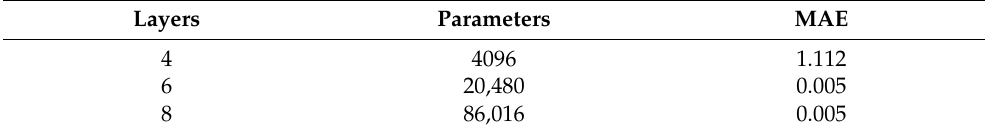
Table 4. MAE under different